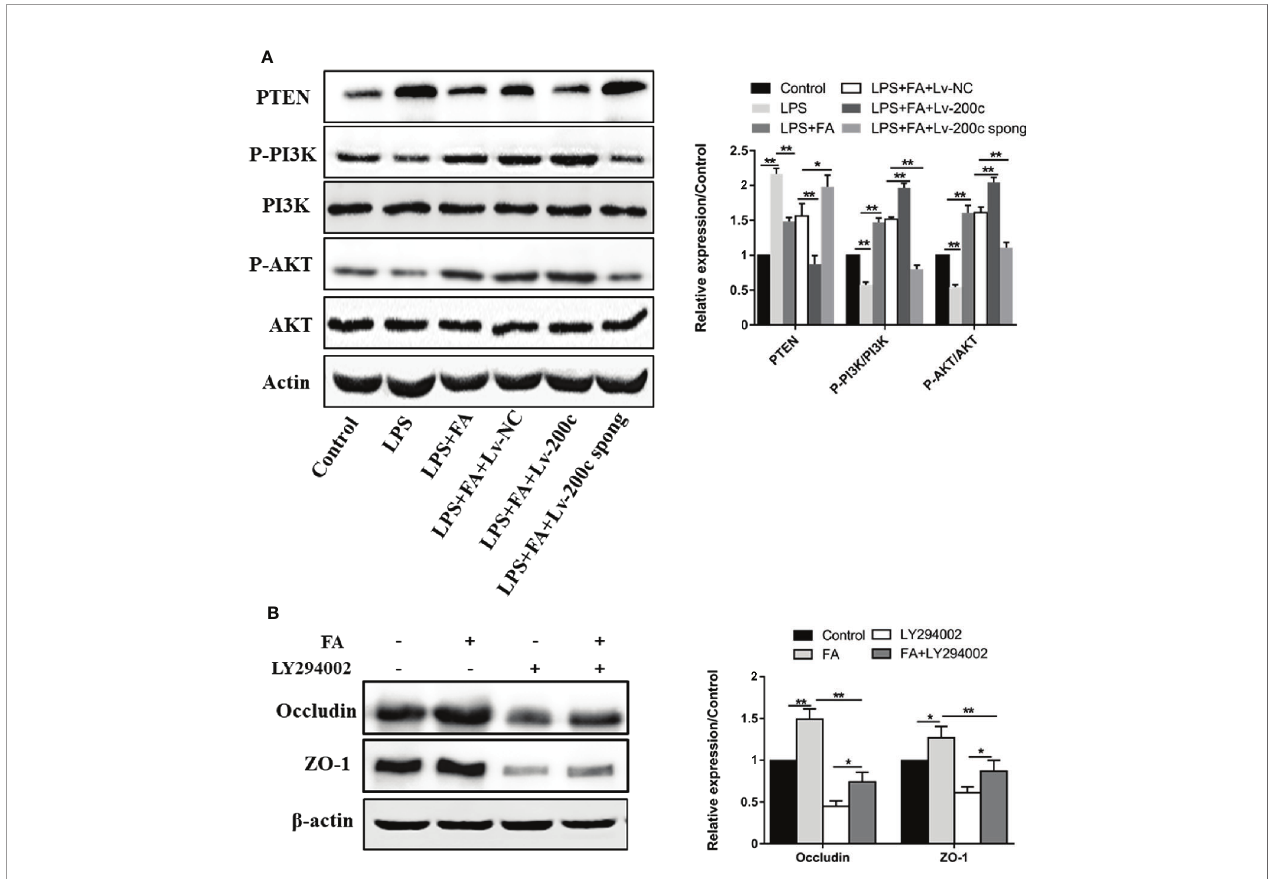
FIGURE 5 | FA attenuated LPS-induced intestinal epithelial barrier dysfunction via activating miR-200c-3p-mediated PTEN/AKT pathway in Caco-2 cells. (A) Cells were transfected with Lv-200c, Lv-200c spong and Lv-NC at an MOI of 15 and incubated at 37°C with 5% CO 2 for 48 h, and then cells were pretreated with FA (100 m M) for 2 h and stimulated with LPS for 24 h. The expression levels of PTEN, PI3K, p-PI3K, AKT and p-AKT were evaluated using western blotting. (B) Caco-2 cells were pretreated with 10 m M LY294002 for 1 h and then treated with 100 m M FA for 2 h. The expression levels of occludin and ZO-1 proteins were evaluated using Western blotting. Data were presented as means ± SD from three independent experiments and differences between means were compared using one-way ANOVA with Tukey ’ s multiple comparisons test. * P < 0.05; ** P <